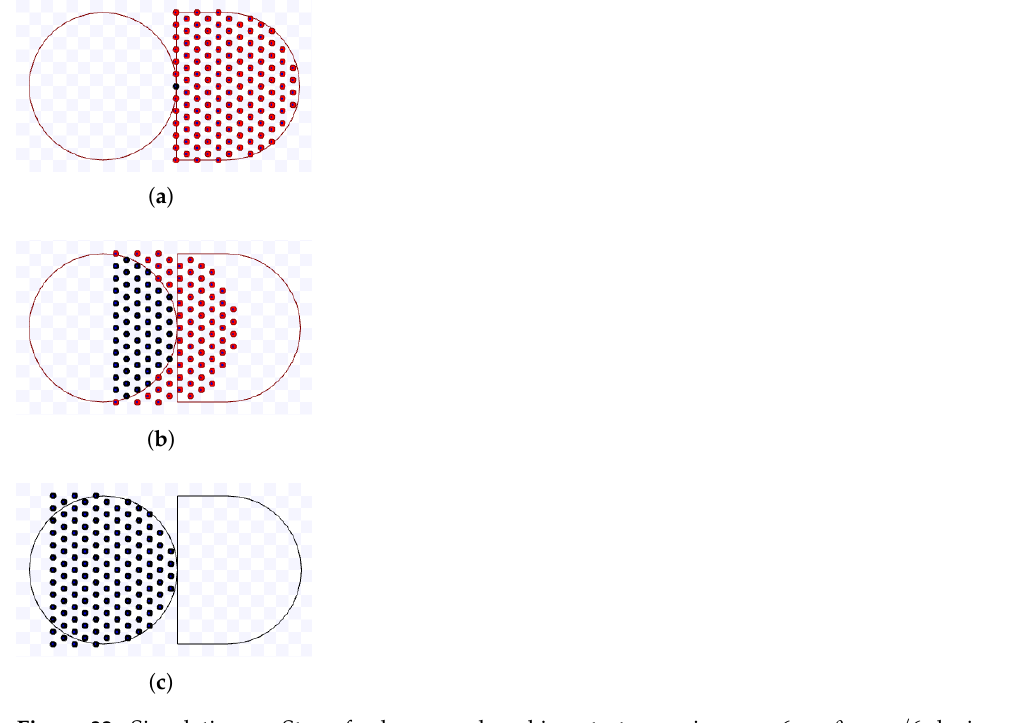
Figure 32. Simulation on Stage for hexagonal packing strategy using s = 6 m, θ = π / 6 during T = 10 s. Available on https://youtu.be/-KX7ziOp8b0, accessed on 12 June 2022. ( a ) 0 s: beginning of the simulation.; ( b ) After 4.9 s; ( c ) 10 s: ending of the simulation.